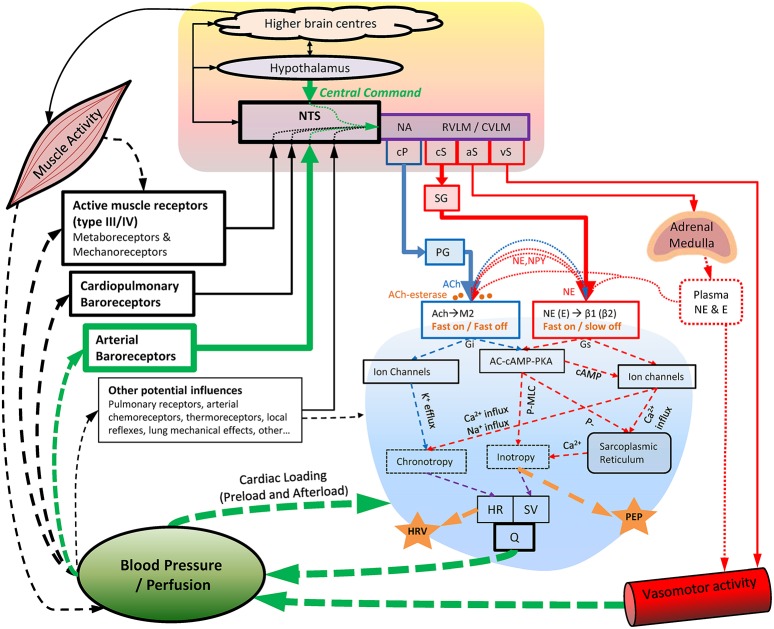
Key aspects of cardiovascular autonomic regulation, particularly during exercise and recovery. Blood pressure appears to be the primary regulated variable. Acetylcholine-esterase at the parasympathetic-cardiac junction facilitates rapid “On” and “Off” signaling (<1 s), whereas sympathetic “Off” effects are substantially slower (20+ s). Note the indirect nature of HRV and PEP as indices of cardiac parasympathetic and sympathetic activity, respectively, as well as the substantial “cross talk” (pre-and post-junctional) of cardiac sympathetic/parasympathetic effects. Also note the common pathways through which different dosages of exercise (intensity, duration, and modality) may influence cardiac autonomic regulation. AC-cAMP-PKA, adenylate-cyclase/cyclic-AMP/Protein-kinase-A cascade; ACh, acetylcholine; aS, sympathetic outflow to adrenal medulla; β1 (β2), Beta1 (Beta2) adrenergic receptors; Ca2+, calcium ions; cP, cardiac parasympathetic outflow; cS, cardiac sympathetic outflow; CVLM, caudal ventrolateral medulla; E, epinephrine; Gi, G-protein inhibitory subunit; Gs, G-protein stimulatory subunit; HR, heart rate; HRV, heart rate variability; K+, potassium ions; M2, M2 muscarinic receptor; MLC, myosin light chain; NA, nucleus ambiguus; Na+, sodium ions; NE, norepinephrine; NPY, neuropeptide Y; NTS, Nucleus Tractus Solitarii; P-, phosphorylation; PEP, pre-ejection period; PG, parasympathetic ganglia; Q, cardiac output; RVLM, rostro ventrolateral medulla; SG, sympathetic ganglia; SV, stroke volume; vS, vascular sympathetic outflow.